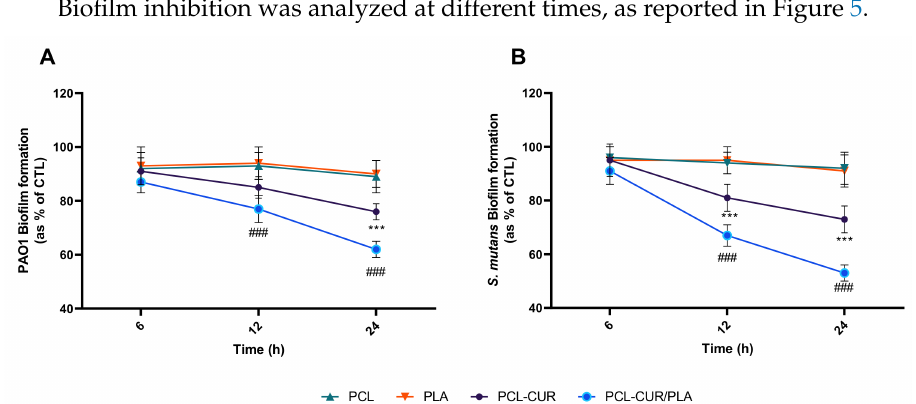
Figure 5. Antibiofilm activity of curcumin-loading membranes. Biofilm formation was evaluated by CV assay, after 6, 12, and 24 h of incubation at 37 ◦ C in the presence of PAO1 ( A ), and Streptococcus mutans ( B ) as described in the material and methods section. Biofilm formation was reported as a percentage in comparison to the maximum amount of biofilm produced by PAO1 and Streptococcus mutans grown (bacterial positive controls). For each sample, six different experiments were conducted, and the results expressed as the mean of the values obtained (mean ± SD). Statistically significant variations: *** p < 0.001 versus PCL and PLA; ### p < 0.001 versus